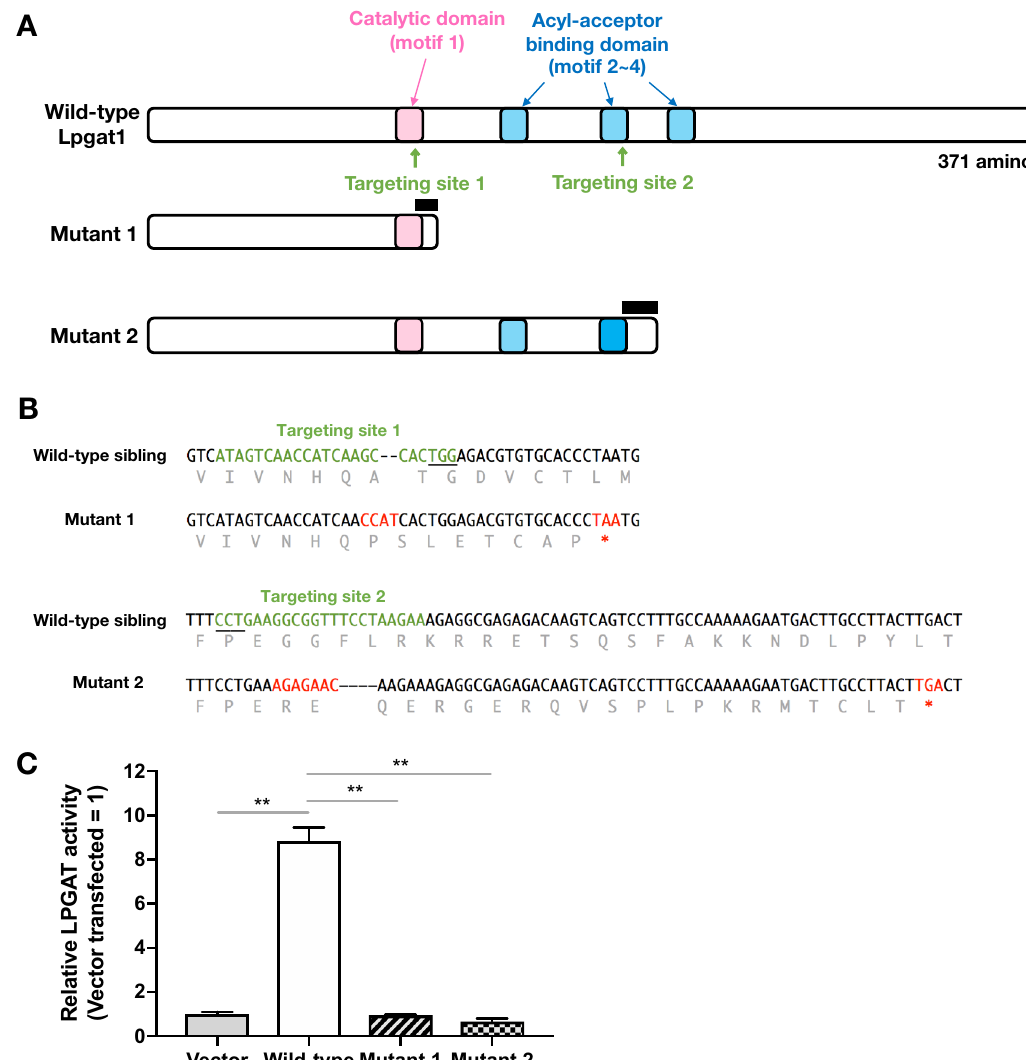
Figure 1. Generation of lpgat1 mutant zebrafish by CRISPR/Cas9 system. ( A ) Domain structure and targeting sites for disruption of zebrafish Lpgat1 and schematic diagram of mutant Lpgat1 proteins. The active domain (motif 1) and the three acyl-acceptor binding domains (motif 2–4), which are highly conserved in AGPAT family molecules, are indicated by a pink box and blue boxes, respectively. For efficient disruption of Lpgat1 function, two sites near the functional motif were targeted. Both mutants 1 and 2 are predicted to be truncated proteins. The changed amino acid sequences are indicated by black bars. ( B ) Sequence alignment of the mutant alleles with predicted amino acids. Mutated nucleotide sequences and the resulted stop codons are in red. Targeting sites are in green. PAM sequences are underlined. Predicted amino acid sequences are in gray. ( C ) Lysophosphatidylglycerol acyltransferase (LPGAT) activities of wild-type and mutant Lpgat1 proteins. The LPGAT assay was performed using oleoyl lysophosphatidylglycerol (C18:1 LPG), palmitoyl-CoA (C16:0-CoA) and the microsomal fraction from HEK293A cells expressing wild-type or mutant Lpgat1 proteins. Relative LPGAT activities (activity of the microsomal fraction from vector-transfected cells = 1) are shown. The data represents the mean ± S.D. of triplicate measurements. Statistically significant differences are marked with asterisk. ** p < 0.01. Two-way ANOVA, Holm’s multiple comparison test was crosses between heterozygotes survived to 30 dpf. By contrast, the proportions of heterozygotes and wild-type juveniles were almost as expected (wild-type: heterozygotes = 1: 2) (Fig. 4). However, we did not observe any morphological differences among homozygous mutants, heterozygous mutants and wild-type juveniles (data not shown). The cause of abnormalities and death was unclear because about 25% of wild-type juveniles die within two weeks of fertilization. In addition, approximately 40% of eggs obtained from crosses between het- erozygous males and females do not develop due to fertilization abnormalities of the heterozygous males (Fig. 2).